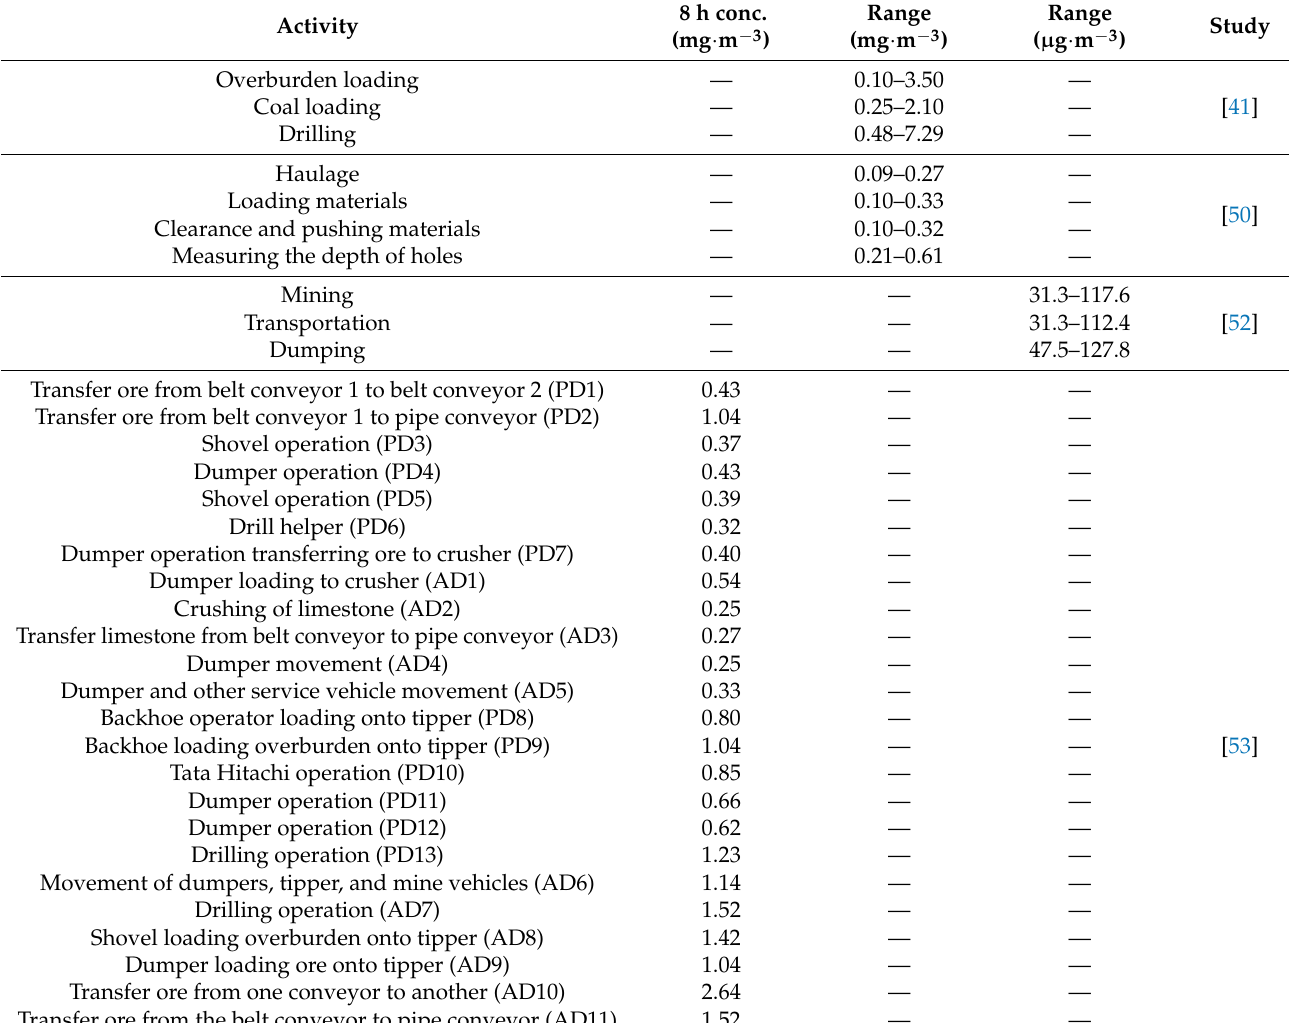
Table 3. Dust concentration according to performed